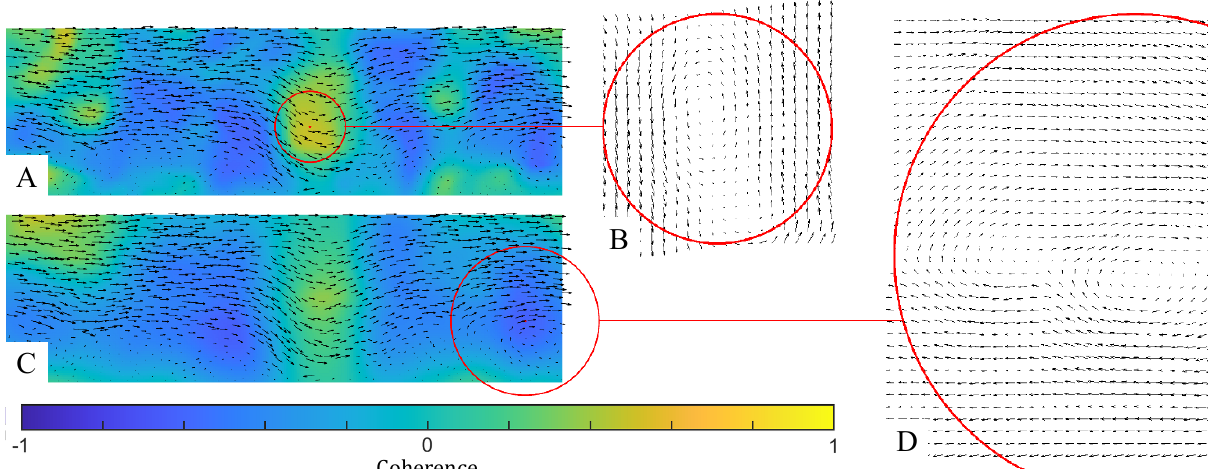
Fig. 4. A. Illustrative field of coherence for a radius 𝑅 = 3.8 µm; B. Local maximum in this field, corresponding to a clockwise (i.e. retrograde) vortex; C. Illustrative field of coherence for a radius 𝑅 = 8.0 µm; D. Local minimum in this field, corresponding to a counter-clockwise (i.e. prograde) vortex.